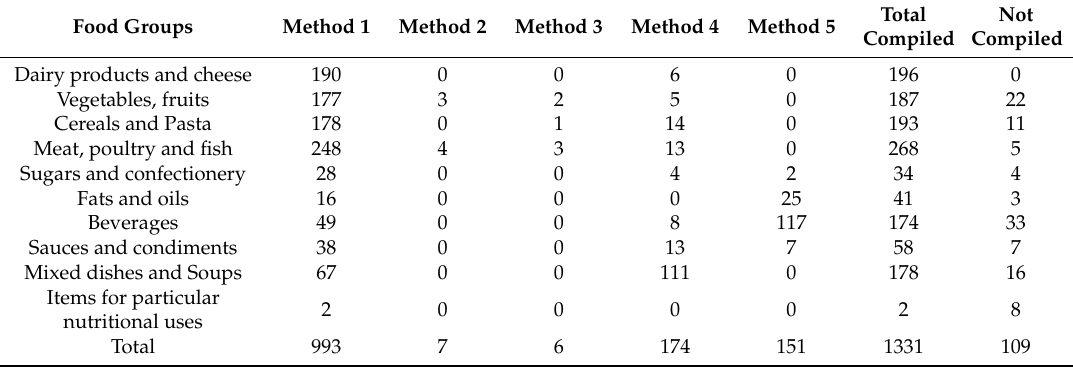
Table 1. Number of food items compiled for BCAA database as function of methods used and food groups. Food items were assigned to different food groups and BCAA content was compiled using five methods (Non-compiled food items are also indicated).